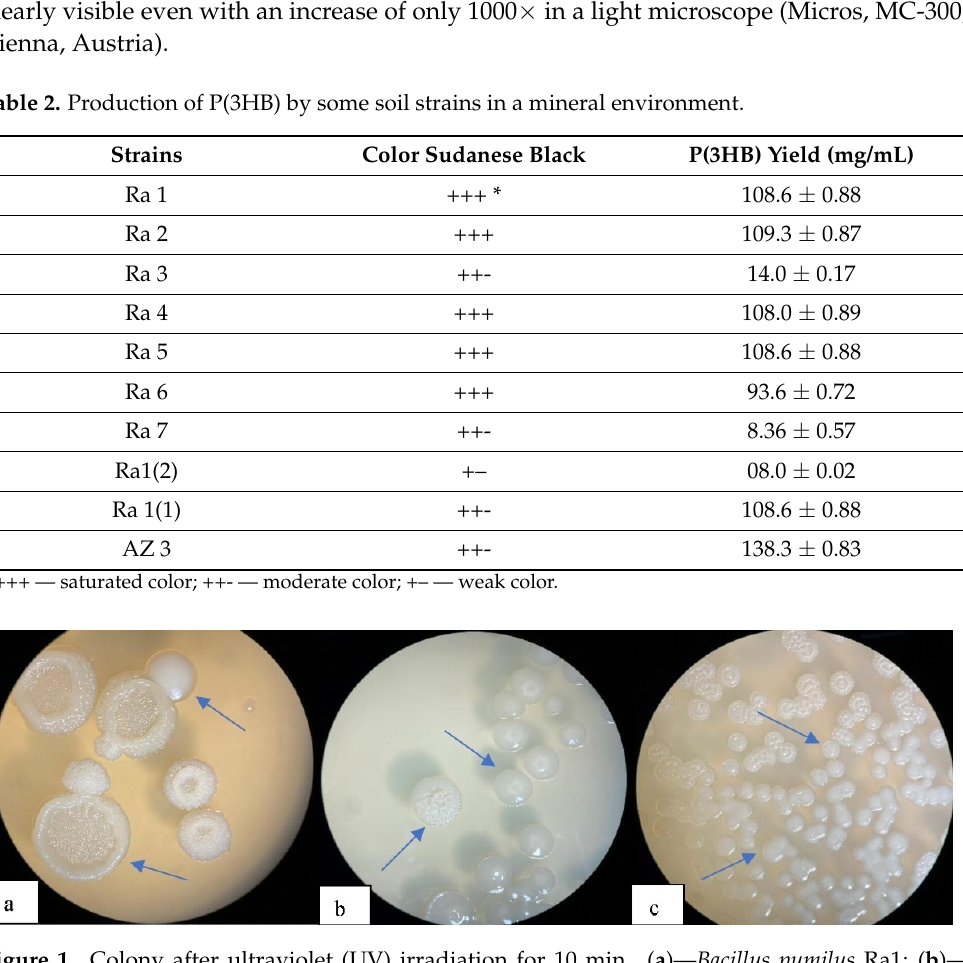
Figure 1. Colony after ultraviolet (UV) irradiation for 10 min. ( a )— Bacillus pumilus Ra1; ( b )— Azotobacter chrocococcum AZ 3 and ( c )— Bacillus megaterium Bm 5.